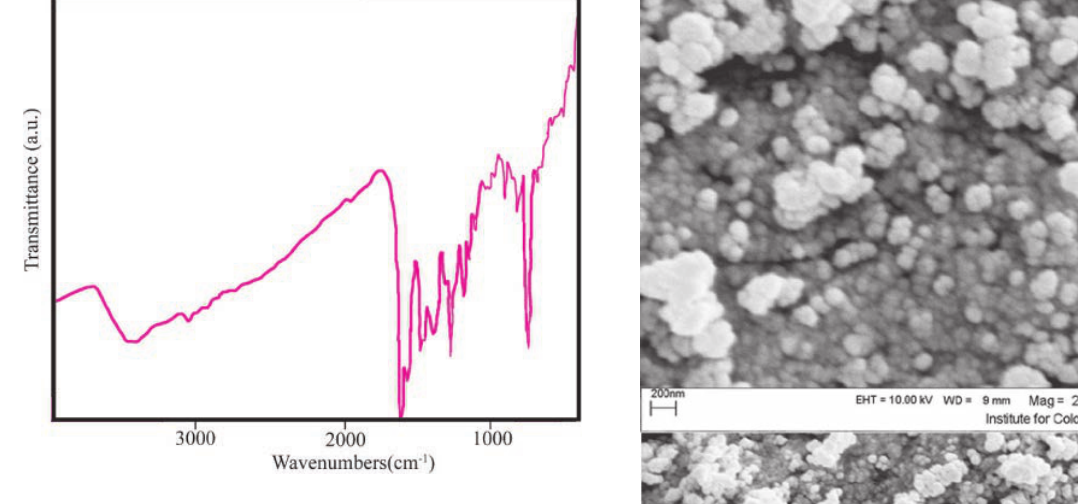
Fig. 2: FTIR spectrum of the Hg(salpn) precursor.